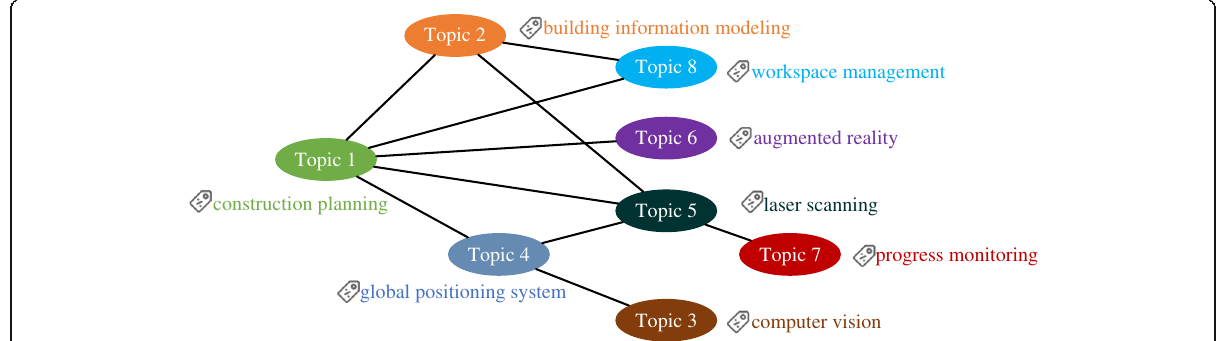
Fig. 6 Significant citation relationships between